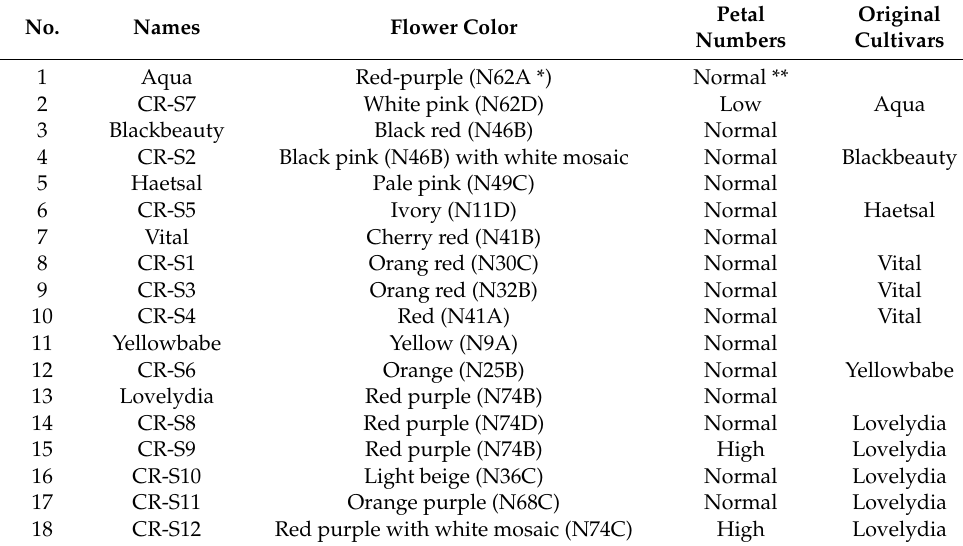
Table 1. Origin and morphological characteristics of Rose genotypes used in this study.